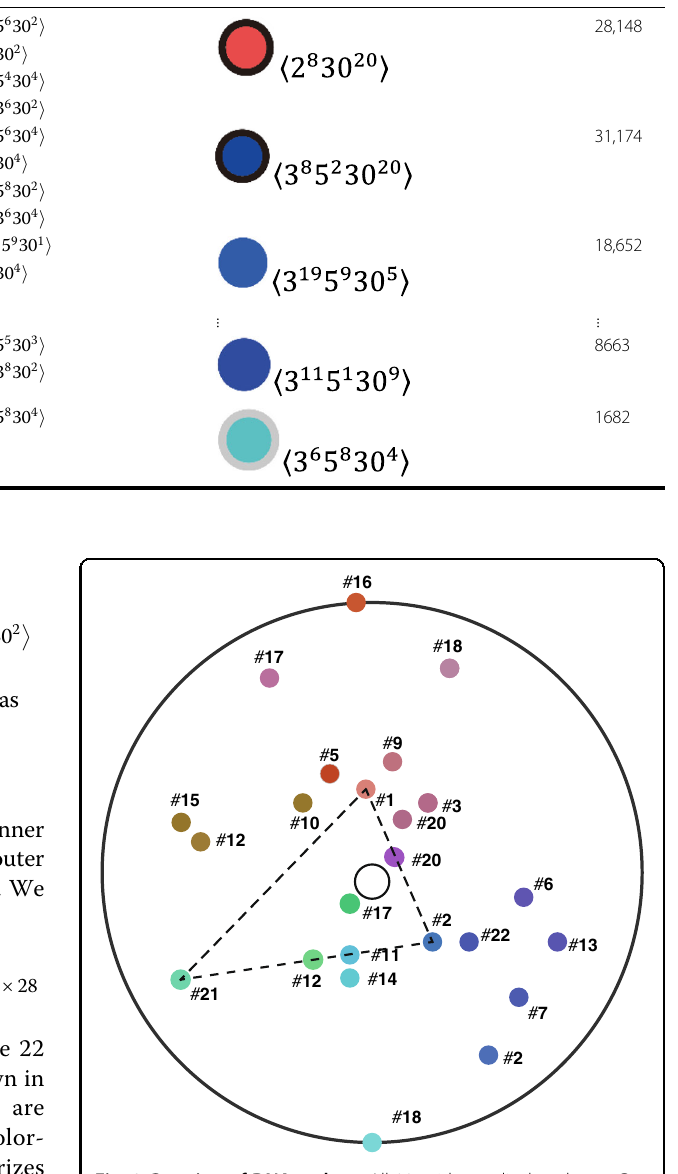
Fig. 8 C 235 ring of DNA codons. All 22 acids are displayed on a C 235 ring. It is convenient to visualize the complementary and triad- complementary